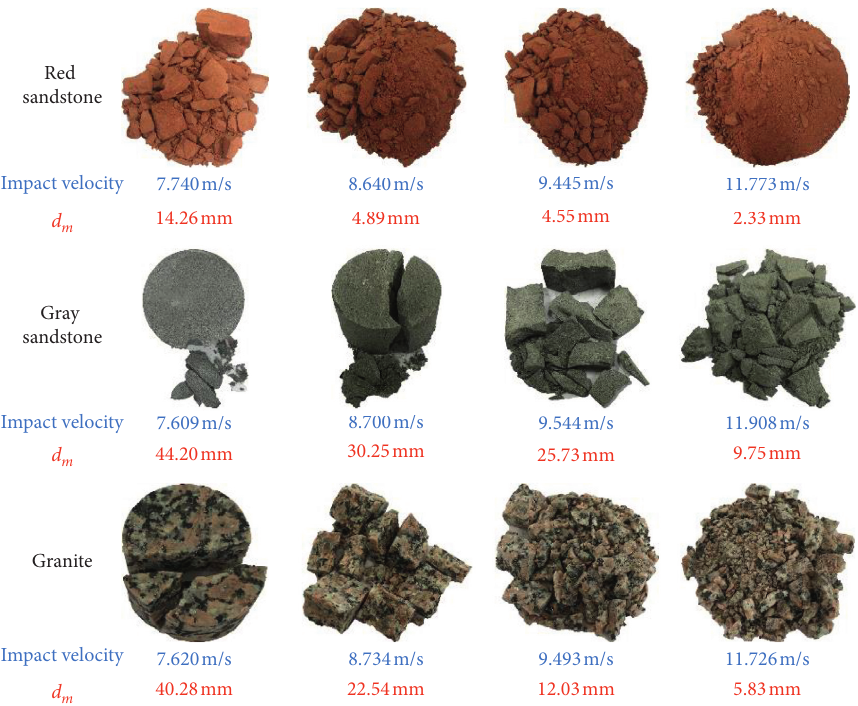
Figure 16: Comparison of fragments of three kinds of